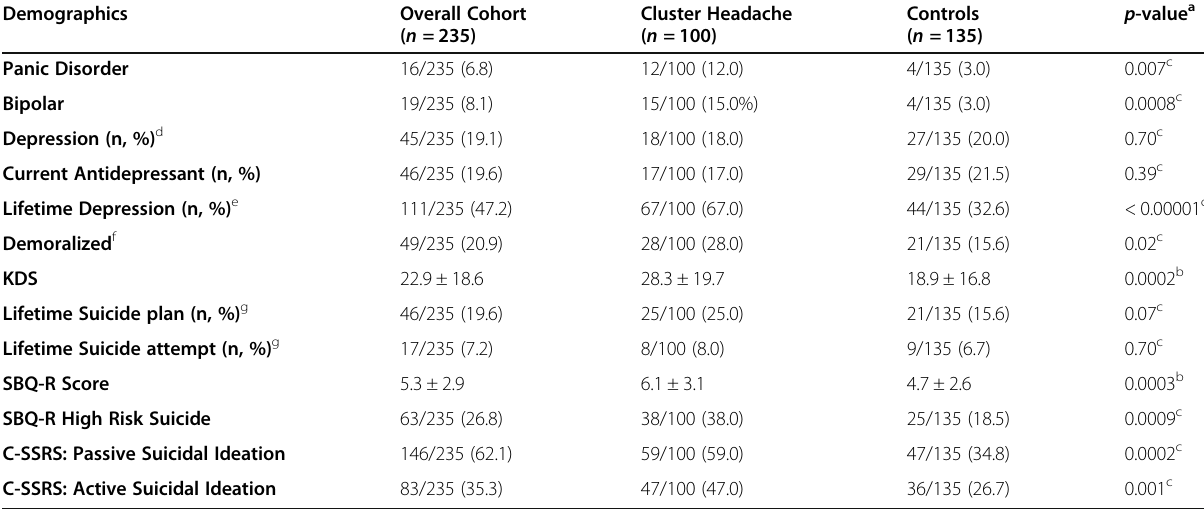
Table 2 Mental Health and Suicidality in Cluster Headache patients and